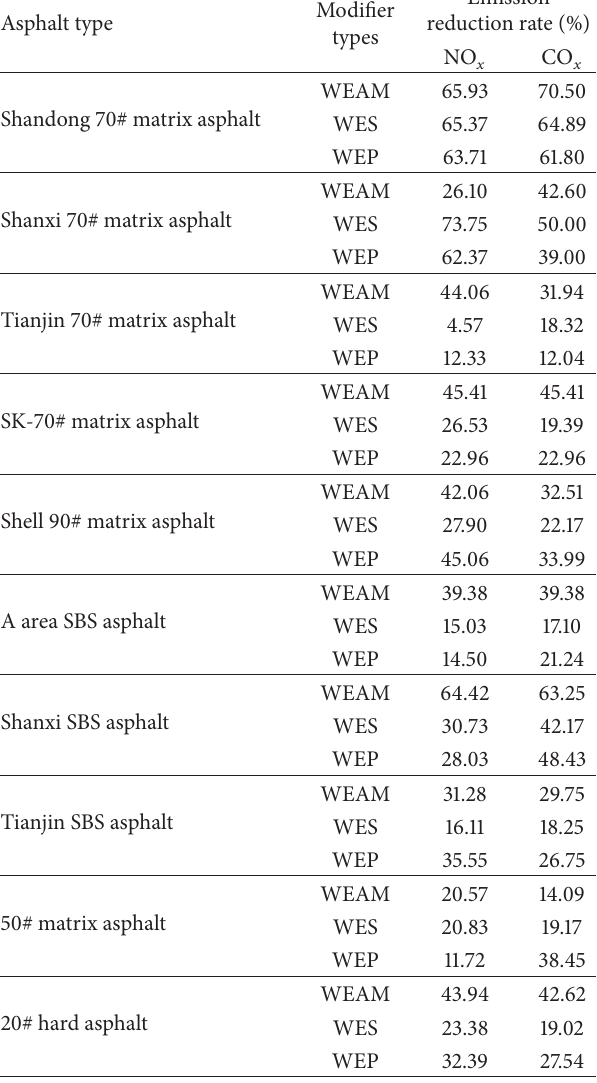
Table 4: Type of asphalt and emission reduction